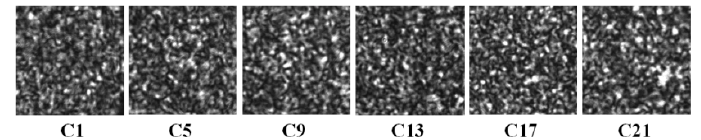
Figure 11. Speckle patterns collected at different measurement locations.